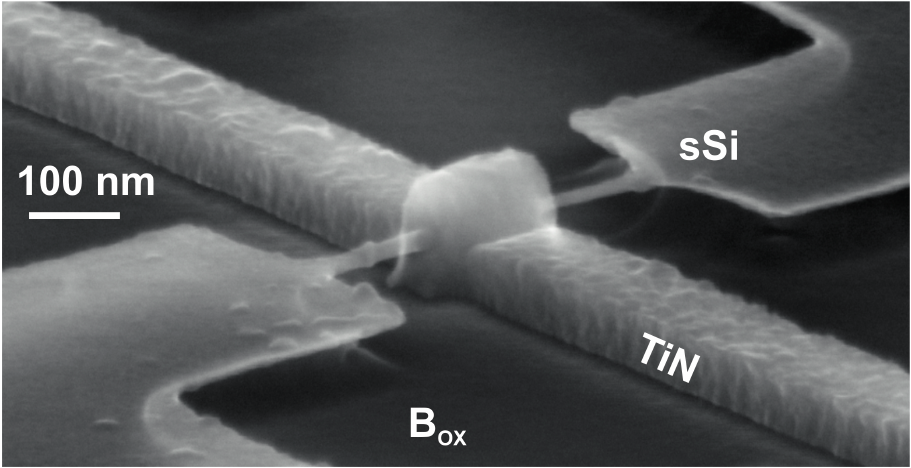
Figure 2: Complementary strained Si GAA Nanowire TFET with suppressed ambipolarity nanowire transisto (Luong et al.,